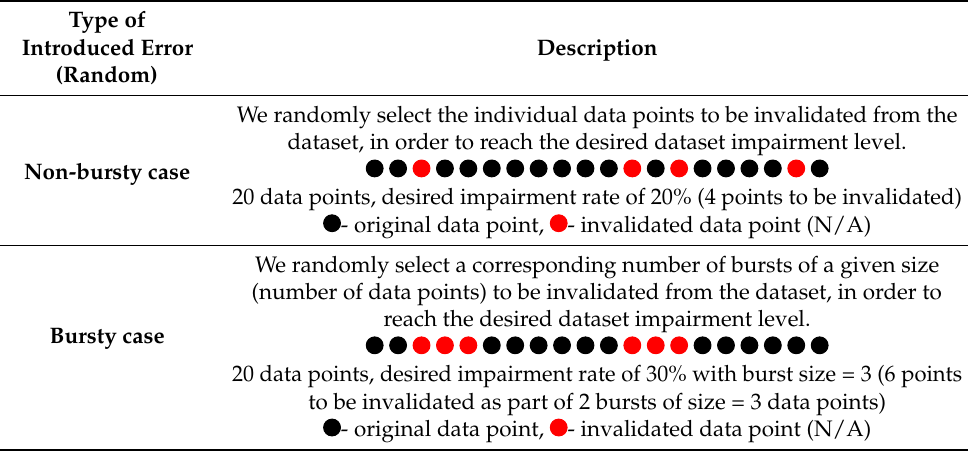
Table 3. The methods used for corrupting the